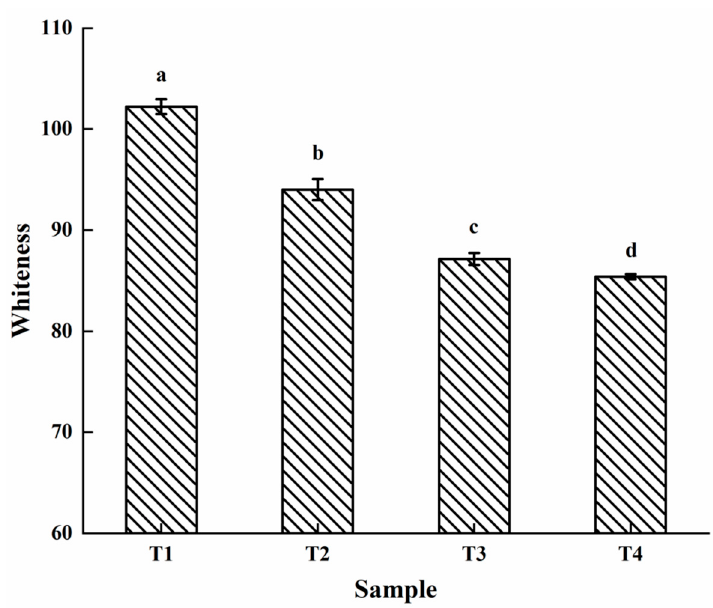
Figure 2. The whiteness of the PSE meat myofibrillar protein gels with varying amounts of added sodium bicarbonate. T1, 0/100 g sodium bicarbonate; T2, 0.2/100 g sodium bicarbonate; T3, 0.4/100 g sodium bicarbonate; T4, 0.6/100 g sodium bicarbonate. Each value represents the mean value ± SE ( n = 3). a–d Different parameter superscripts in the same column indicate significant differences ( p < 0.05).